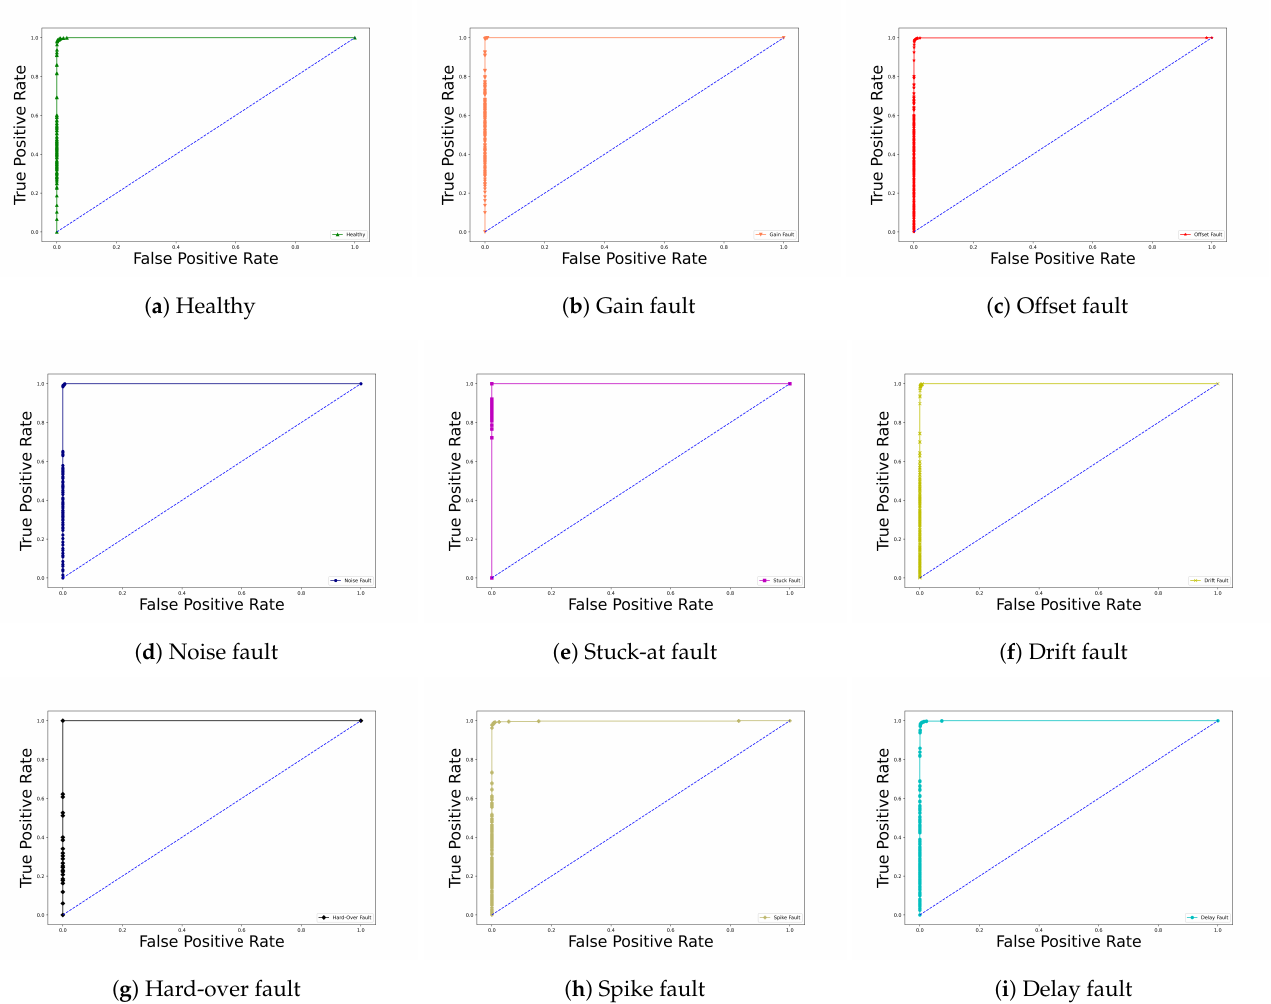
Figure 15. Classification performance in terms of AUC–ROC